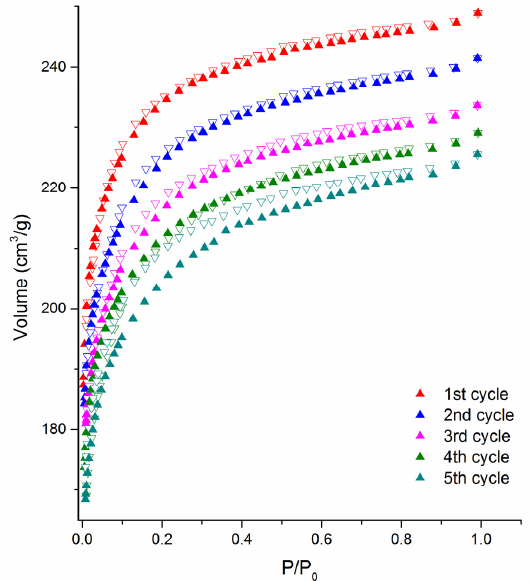
Figure 9. N 2 isotherms of 1 , where the same sample underwent 5 consecutive cycles of sorp- tion/desorption. Full triangles indicate sorption isotherms and hollow triangles indicate desorption isotherms. BET values were as follows: 906 m 2 /g after cycle 1, 860 m 2 /g after cycle 2, 831 m 2 /g after cycle 3, 815 m 2 /g after cycle 4, and 784 m 2 /g after cycle 5.